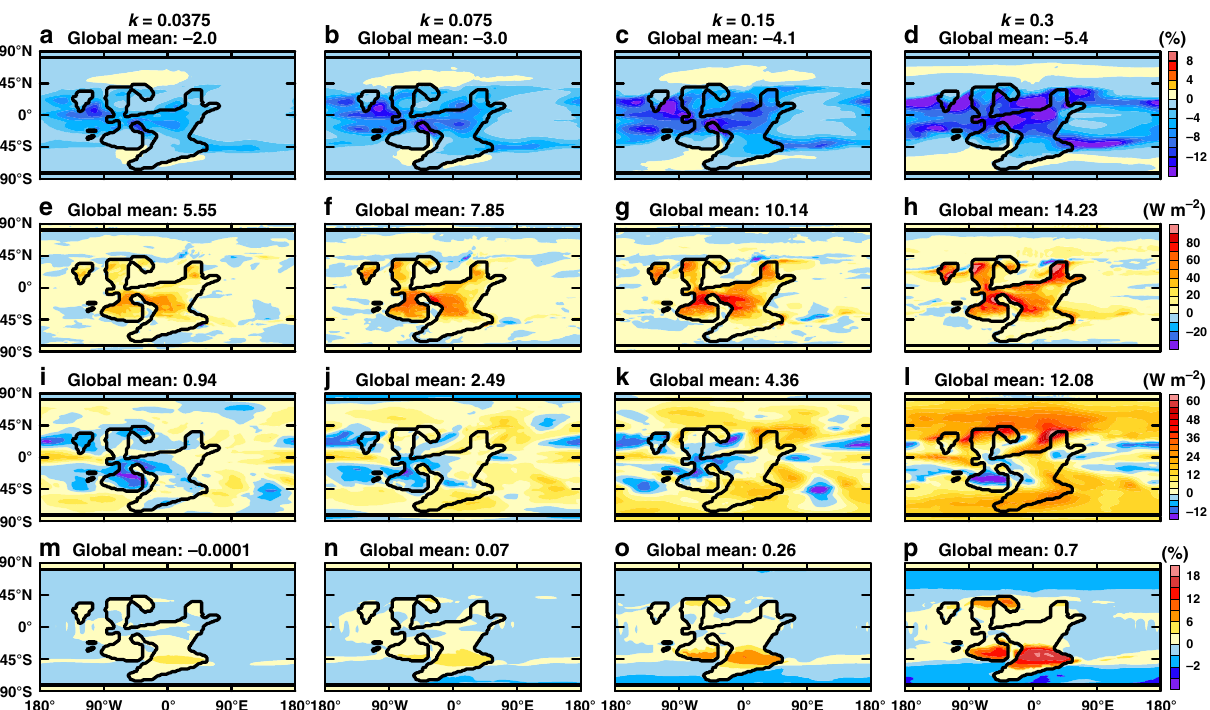
Fig. 3 Warming effect of the dust on the surface. a – d Change of cloud albedo due to dust; e – h The impact of dust on surface sensible heat fl uxes, positive is downward; i – l The impact of dust on downward longwave radiative fl uxes, positive downward; m – p The change of surface albedo due to dust. Each column shows the results for a speci fi c erodibility as labeled on the top. Black contour lines represent continental boundaries. The number in the upper left corner of each panel is the global averaged value. See the Methods section for how changes in cloud albedo, surface sensible heat fl uxes, downward longwave radiative fl uxes, and surface albedo due to dust are